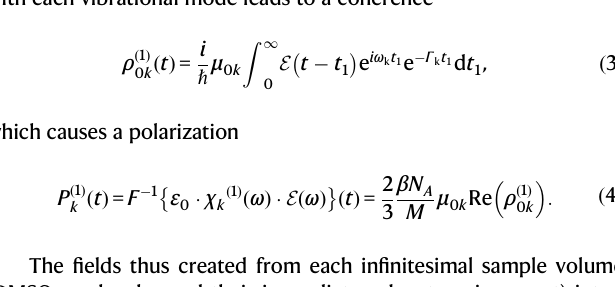
Fig. 2b, c and Fig. 3c, d were obtained from the total susceptibility as described in the Supplementary Information.